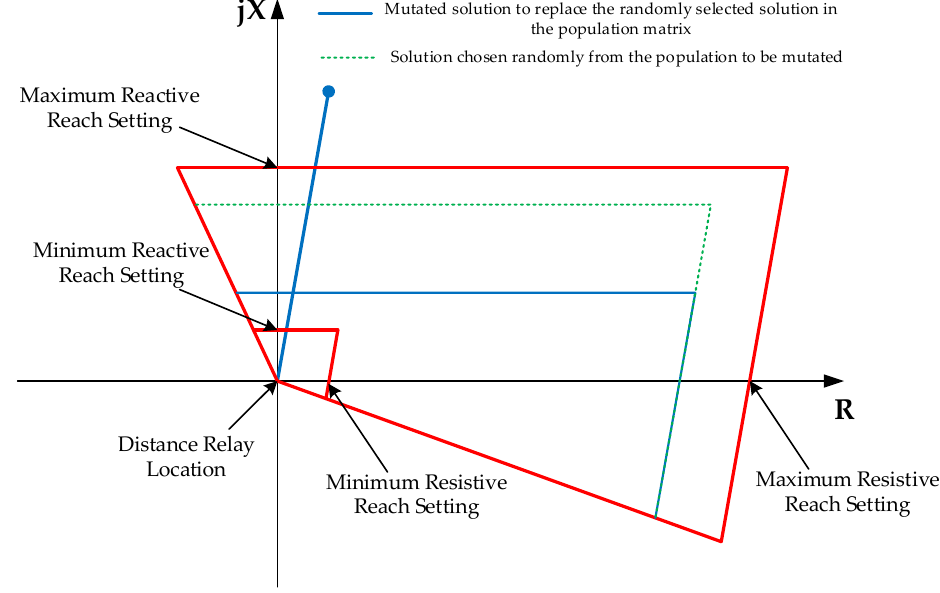
Figure 10. Example of the mutation operator for Xreach to be the variable taking part in the mutation process.